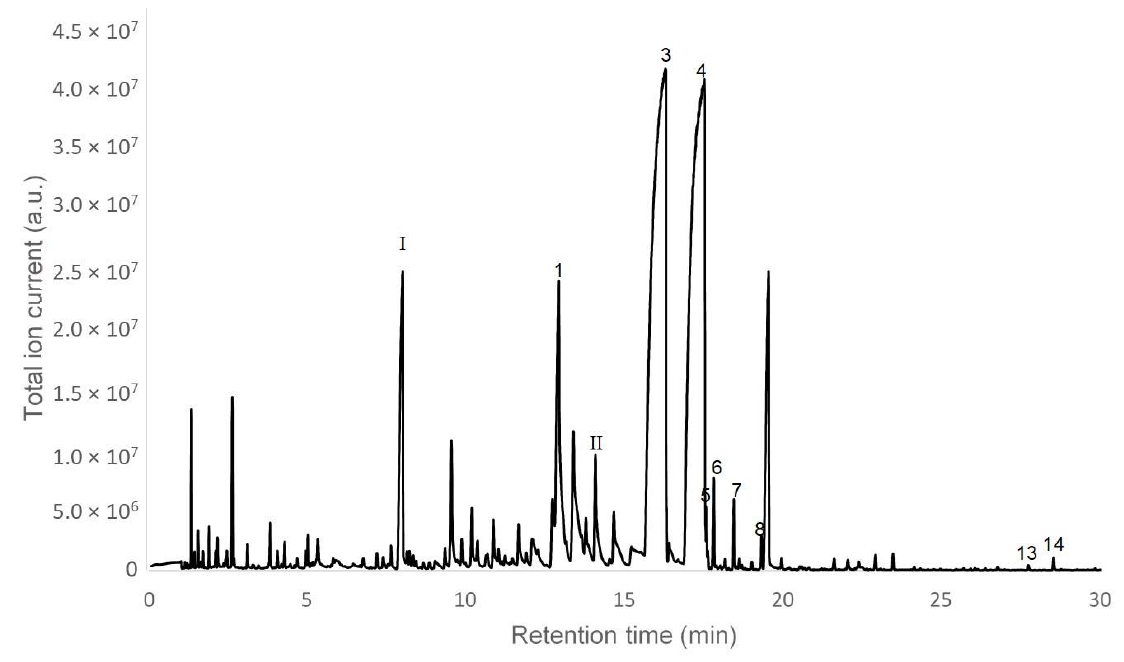
Figure 1. HS-SPME/GC–MS chromatogram of the volatile composition of lemongrass byproduct hydrolate. Numbers above correspond to the peak numbers from Table 1. I—Myrcene. II—Rose furan oxide. The reliability of the identification is given on the basis of mass spectral data (Wiley 275 Library). Table 4. Consumer sensory evaluation and microbial analysis of matcha tea beverages, after 79 days brew preparation, containing different percentages of hydrolate from lemongrass byproduct hydrodistillation.